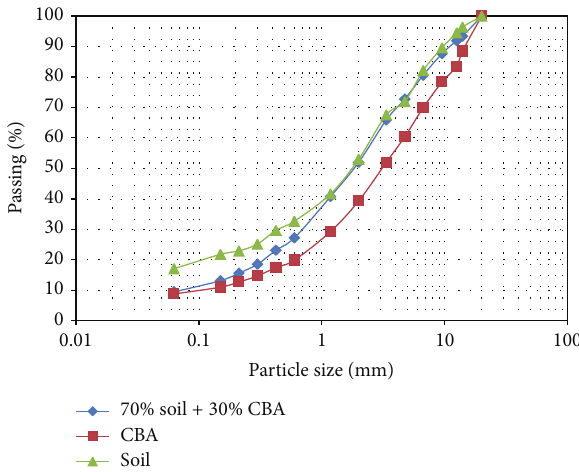
Figure 4: Particle size distribution comparison for soil, CBA, and soil-CBA mix.